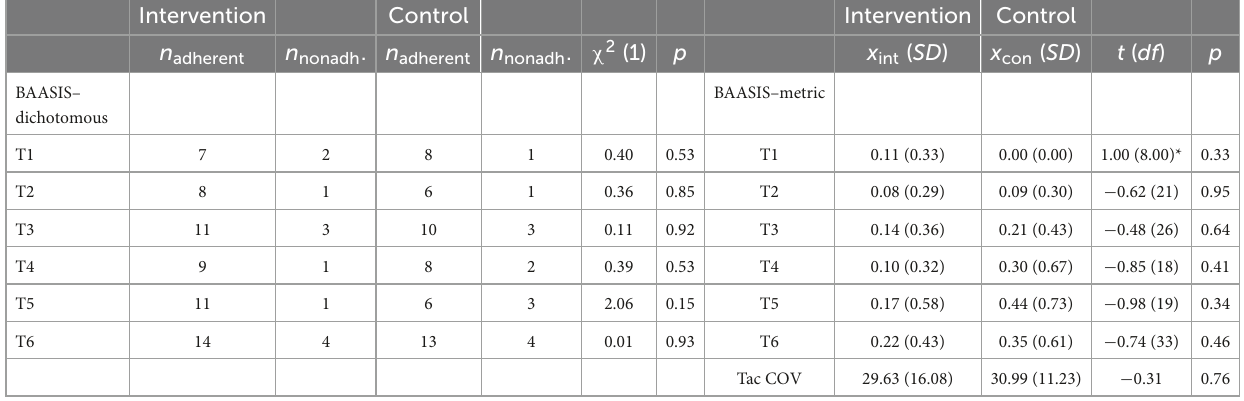
TABLE 3 Statistical tests of intervention main effects.